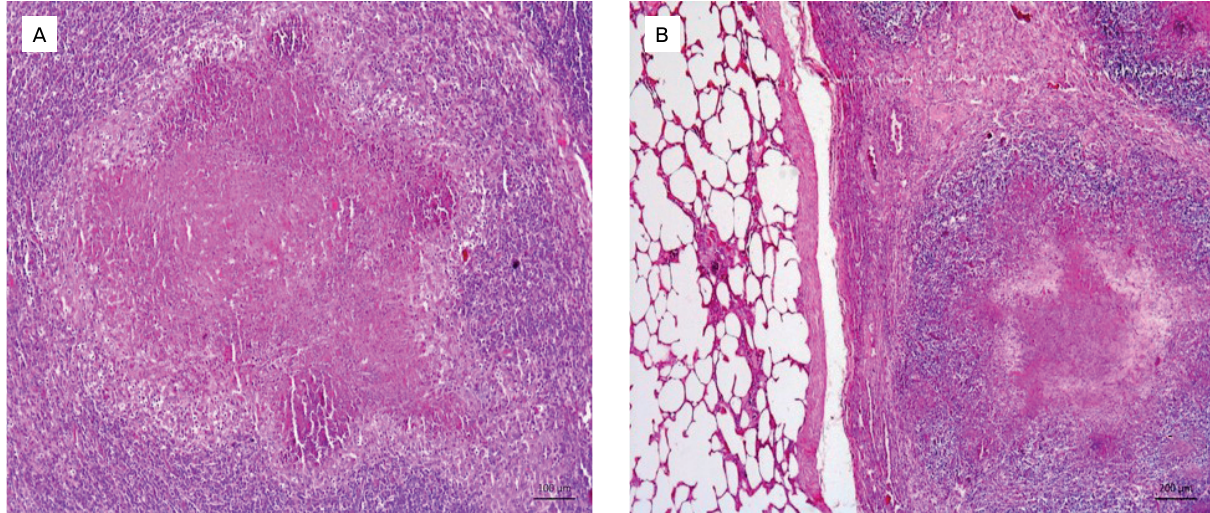
Figure 2. (A) Mediastinal lymph node showing central area of necrosis, with homogeneous eosinophilic material, fragmented nuclei, nuclear remnants and foci of mineralization. Adjacent to the area of necrosis, there is granulomatous inflammation consisting of macrophages, epithelioid cells and numerous lymphocytes. There is also a discrete proliferation of fibrous connective tissue. Obj. 10X, HE. Bar scale = 100 μ m; (B) Lung with extensive granuloma characterized by central area of coagulative necrosis, surrounded by inflammatory infiltrates predominantly of macrophages and epithelioid cells encapsulated by abundant fibrous connective tissue associated with several layers of mononuclear cells. Obj. 5X, HE. Bar scale = 200